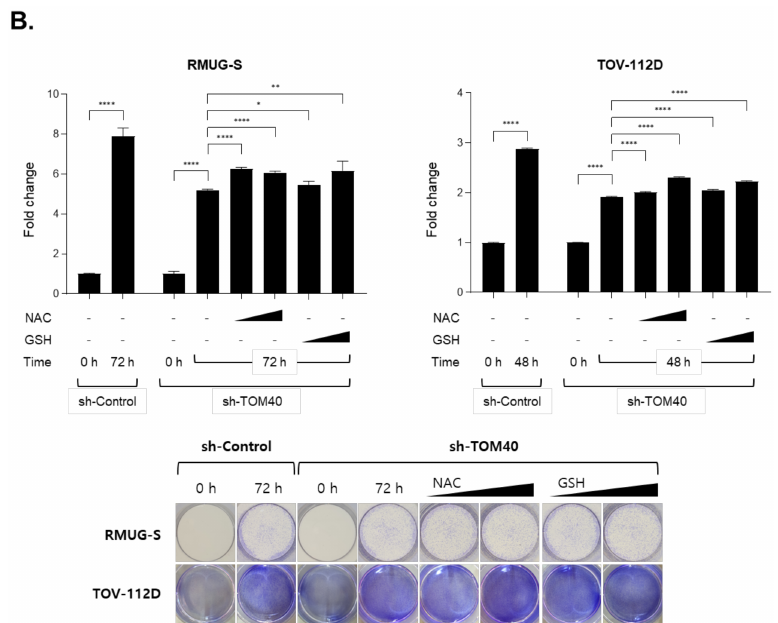
Figure 5. The knockdown of TOM40 expression generates intracellular reactive species which reduce cell growth. ( A ) Epithelial ovarian cancer (EOC) cells that stably express sh-control and sh-TOM40 were seeded at 1 × 10 6 cells in a 60-cm culture dish. The cells were stained with 20 µ M 2’,7’-dichlorofluorescin diacetate (DCFDA) for 30 min at CO 2 incubator (5% CO 2 and 37 ◦ C). The levels of DCFDA staining were measured by FACS analysis. Representative images of histograms: quantification of the percentage of cells in shown the blue line region of histogram. The white area is sh-control cells, while the green is sh-TOM40 cells in histogram. The results are expressed as the mean ± S.D., n = 4 (TOV-112D and OVCAR-3); n = 6 (OVCA-429 and RMUG-S). *** p < 0.001 and **** p < 0.0001. ( B ) EOC cells that stably express sh-control and sh-TOM40 were seeded at 3 × 10 5 RMUG-S and 2 × 10 5 TOV-112D cells in a 24-well plate. The sh-TOM40-expressed RMUG-S cells were treated with 0.25 mM N-acetyl-L-cysteine (NAC), 0.5 mM NAC, 0.5 mM glutathione (GSH), or 1 mM GSH for 72 h. The sh-TOM40 expressed TOV-112D cells were treated with 0.25 mM NAC, 1 mM NAC, 0.5 mM GSH, or 1 mM GSH for 48 h. The growth rate was measured by crystal violet assay. Representative images of the crystal violet stained cells (bottom panel): Data in the bar graph are expressed as the mean of fold change ± S.D., n = 4. * p < 0.05; ** p < 0.01; and **** p < 0.0001.